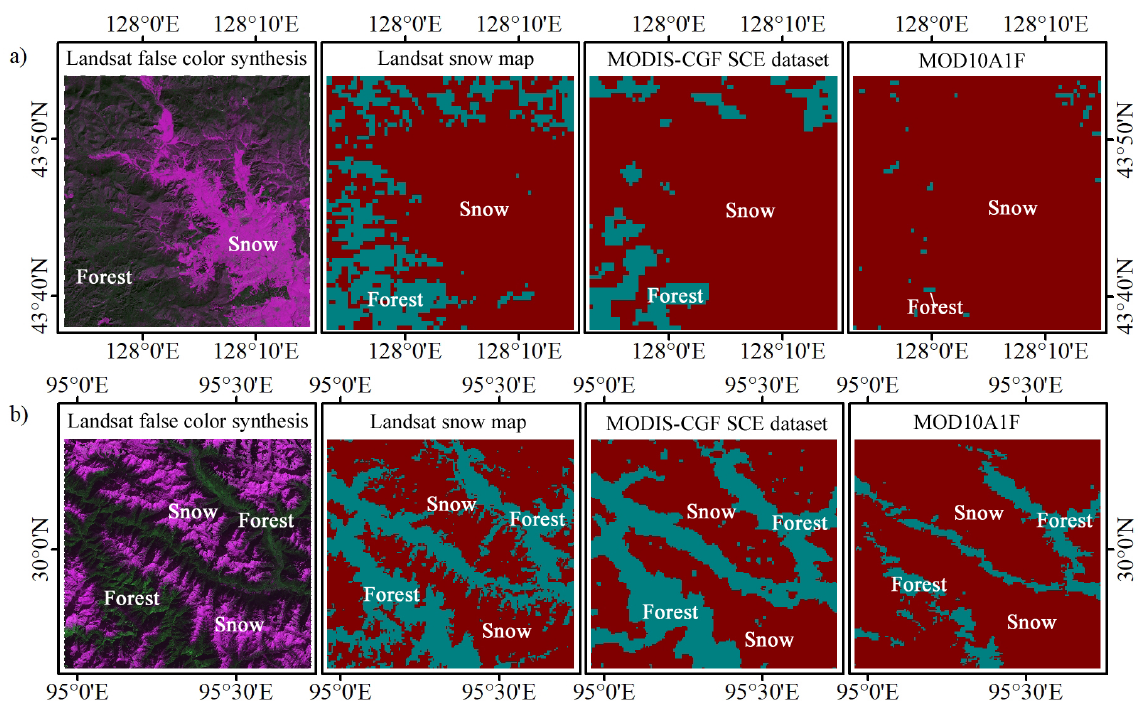
Figure 11. Intuitional improvements of CGF SCE in two representative forest areas: (a) an example in a Northeast China forest region; (b) an example in the Qinghai–Tibet Plateau forest